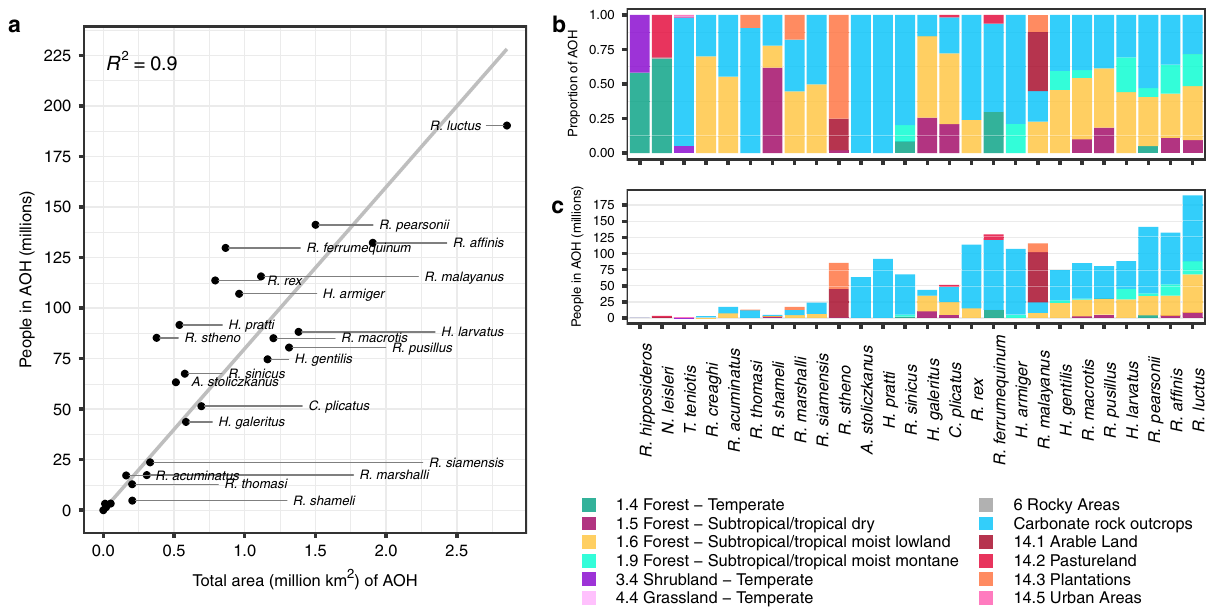
Fig. 1 Relationships among area of habitat (AOH) size, number of people, and habitat proportions. a Scatterplot showing the total number of people living in each AOH versus the total area, for each SARSr-CoV bat host species. A best- fi t line was fi t through the origin, for which the R 2 is displayed. The four unlabeled species at the bottom left corner are (left to right): R. hipposideros , N. leisleri , T. teniotis , and R. creaghi . b Proportion of each habitat type (by area) within species AOHs. c People living in the AOH of each species, separated by habitat type. For b and c , species are listed in order of increasing AOH size, and the species order is the same in both panels. Genus abbreviations in all panels: A . = Aselliscus , C . = Chaerephon , H . = Hipposideros , N . = Nyctalus , R . = Rhinolophus , T . = Tadarida .